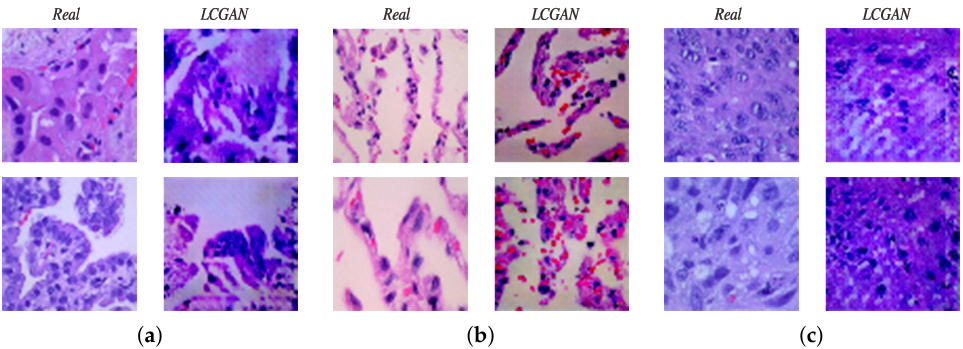
Figure 5. Comparison between real and LCGAN images: ( a ) lung adenocarcinoma, ( b ) lung benign, ( c ) lung squamous cell carcinoma.